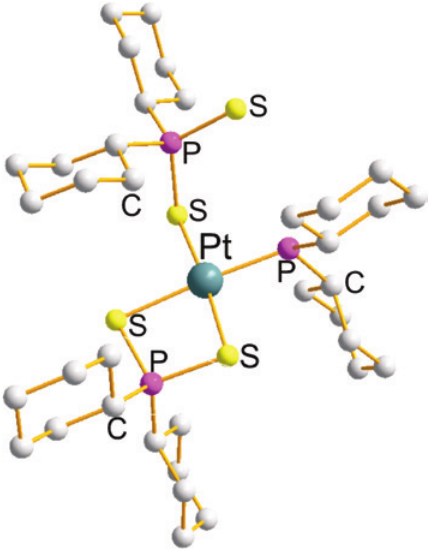
}{ η 2 -S P(cy-hexyl) 2 2